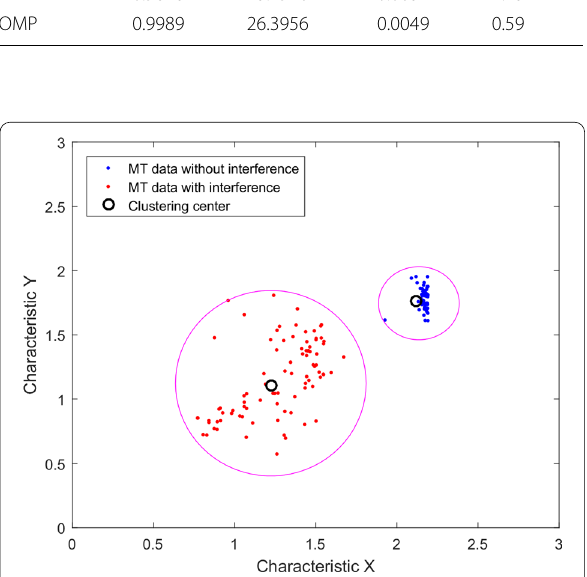
Fig. 3 FCM clustering effect of the sample library signals. Characteristic X and Y represent the RCMDE value when the scale factor is 1 and 2,